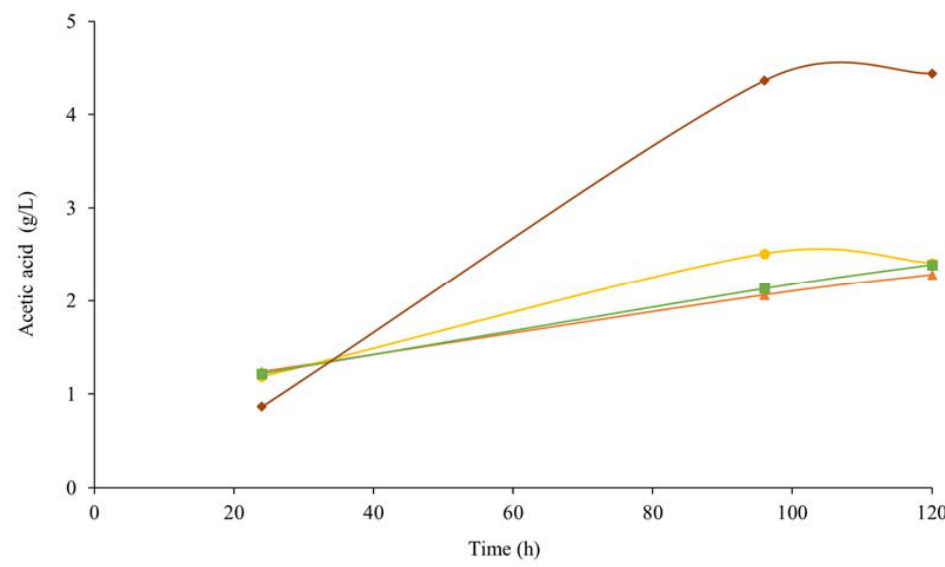
Figure 3. Acetic acid production by Clostridium carboxidivorans during syngas fermentation in ATCC® 2713 (red diamond), ATCC® 2713 with 0.07% ( v/v ) Tween® 80 (orange triangle), ATCC® 2713 with 0.15% ( v/v ) Tween® 80 (yellow circle), and ATCC® 2713 with 0.3% ( v/v ) Tween® 80 (green square).